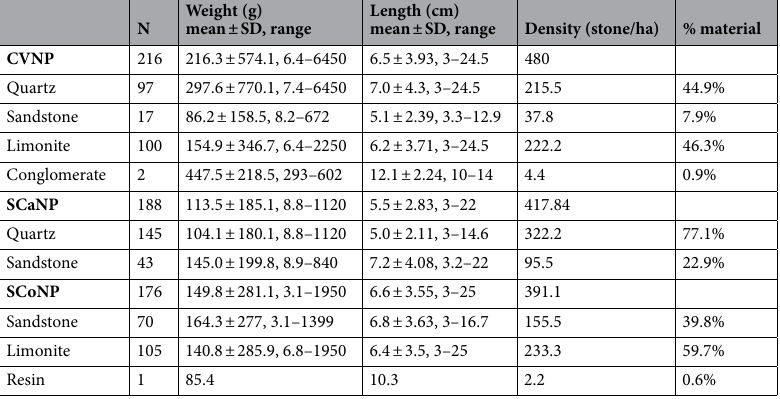
Weight (g) N mean ± SD,